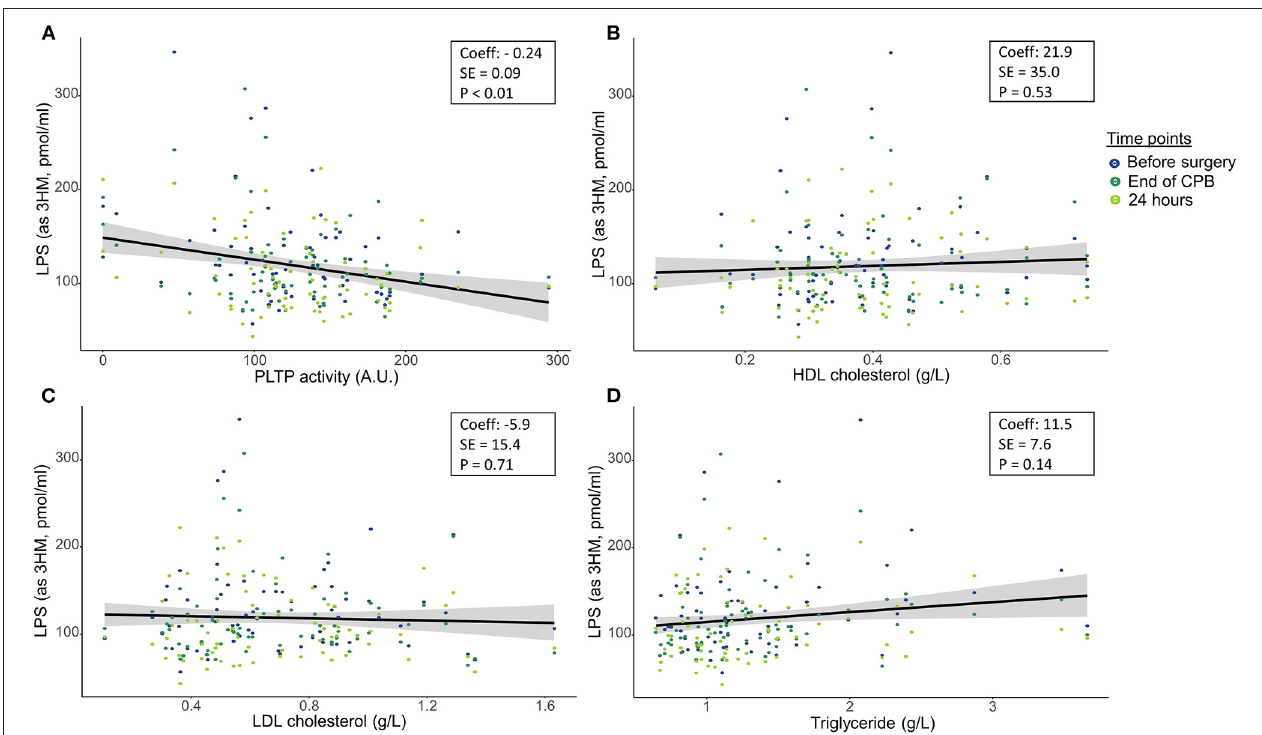
FIGURE 1 | Association between lipopolysaccharide concentrations at the three perioperative time-points and pre-operative (A) phospholipid transfer protein, (B) HDL cholesterol, (C) LDL cholesterol and (D) Triglycerides. LPS, Lipopolysaccharide; 3HM, 3-hydroxymyristate; PLTP, phospholipid transfer protein; HDL, High density lipoprotein; LDL, low density lipoproteins. Plain lines are regression lines using the least squared methods. P -values were computed using mixed linear modeling to handle repeated measures. Coeff: Regression coefficient; SE: Standard